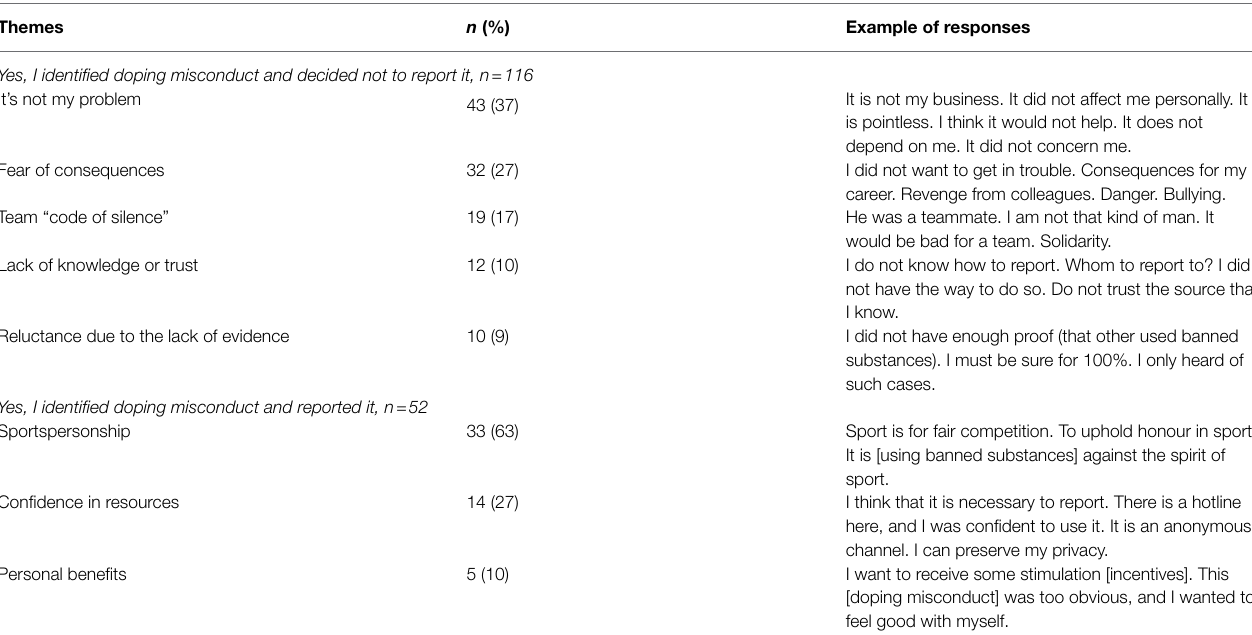
TABLE 4 | Athletes’ reasons for reporting (or not) doping misconduct: emerged themes and responses collected from the open-ended question. Themes n (%) Example of